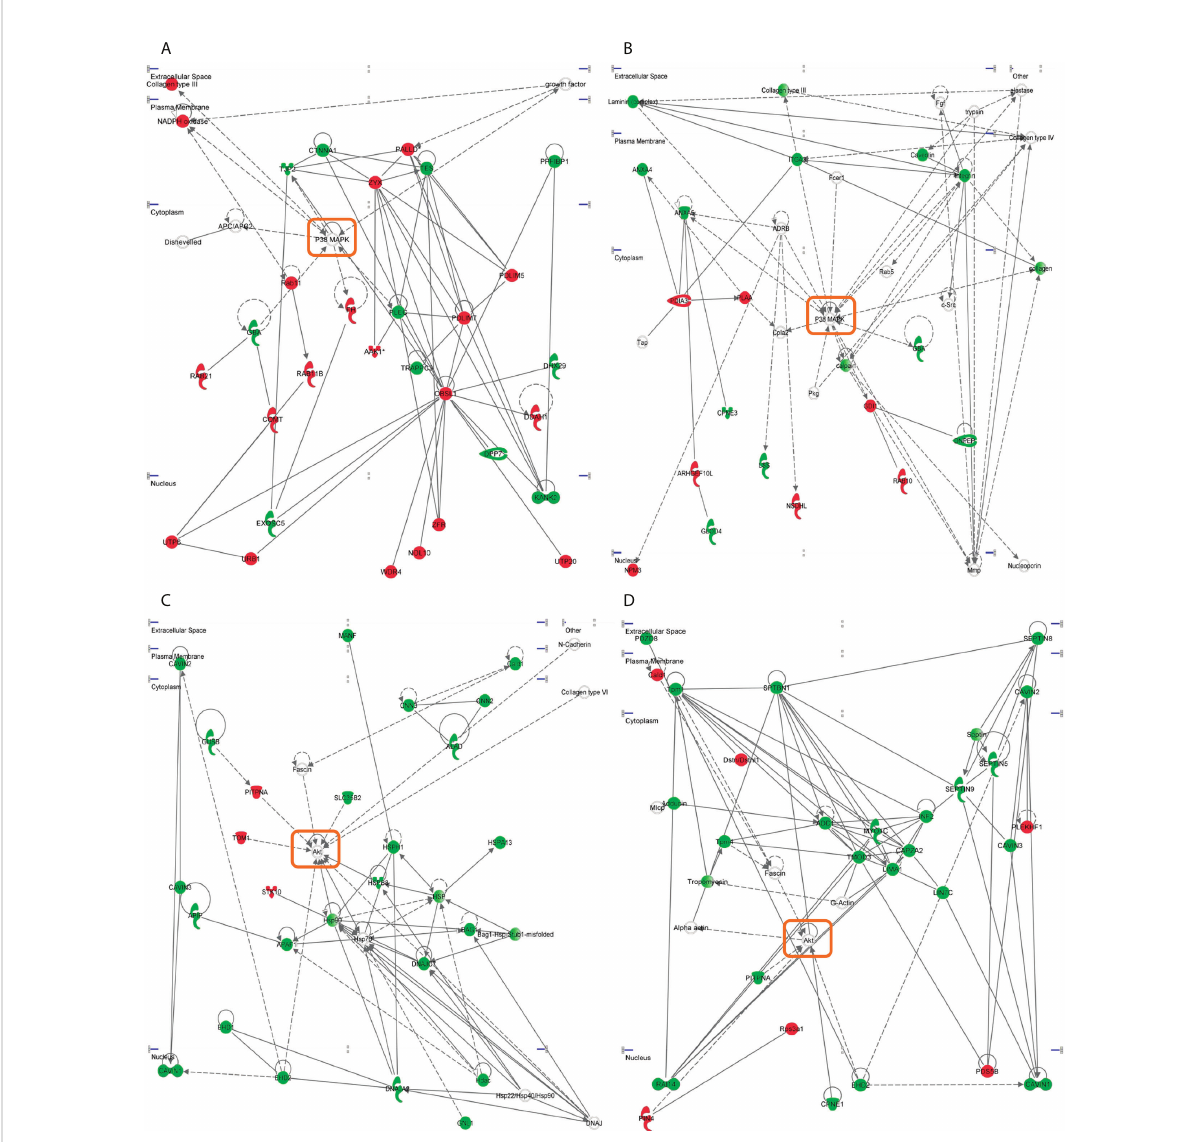
FIGURE 4 Representative functional protein interactome maps for differentially expressed proteins in GFP- SARS-CoV-2 structural protein-expressing OBC1 cells. Visual representation of the functional relationships between altered proteome generated by the expression of SARS-CoV-2 structural E protein (A) , S protein (B, C) and M protein (D) in OBC1 cells. Dysregulated proteins are highlighted in red (up-regulated) and green (down-regulated). Orange circles point the principal nodes of the interactome maps. Direct and indirect interactions are represented by continuous and discontinuous lines